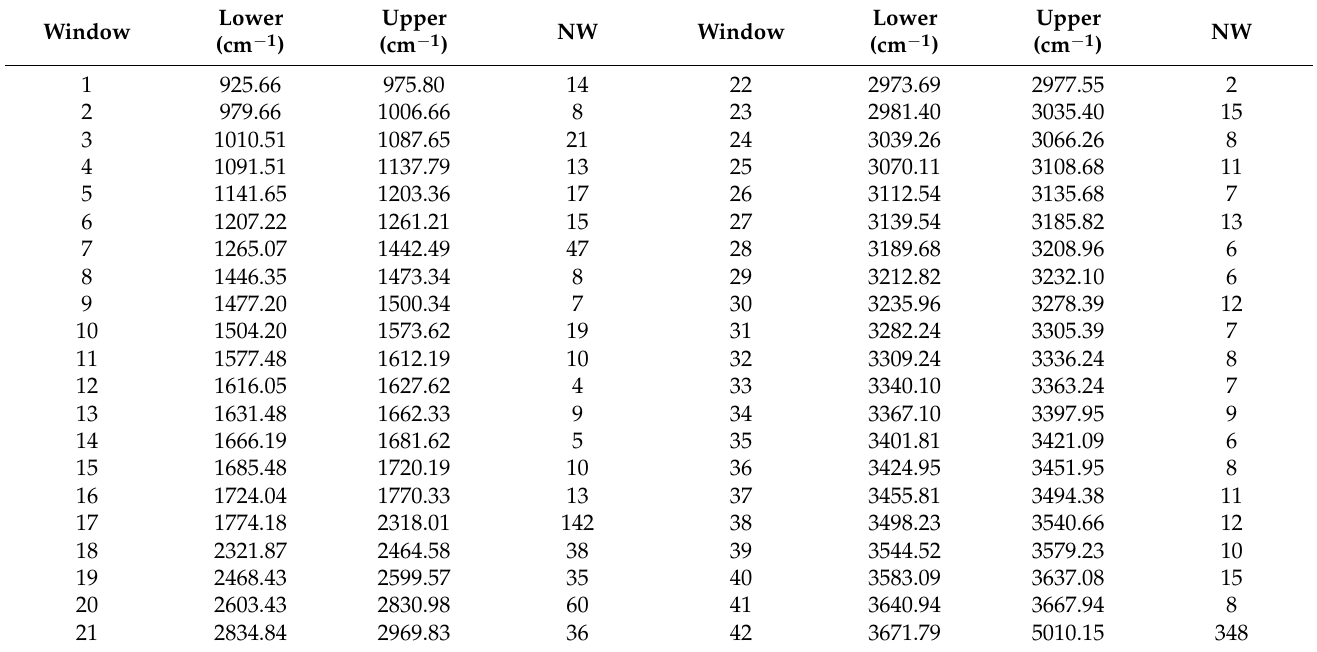
Table 3. Lower and upper wavenumber limits of 42 windows (numbered from 1 to 42) adaptively clustered with 1060 wavenumbers.